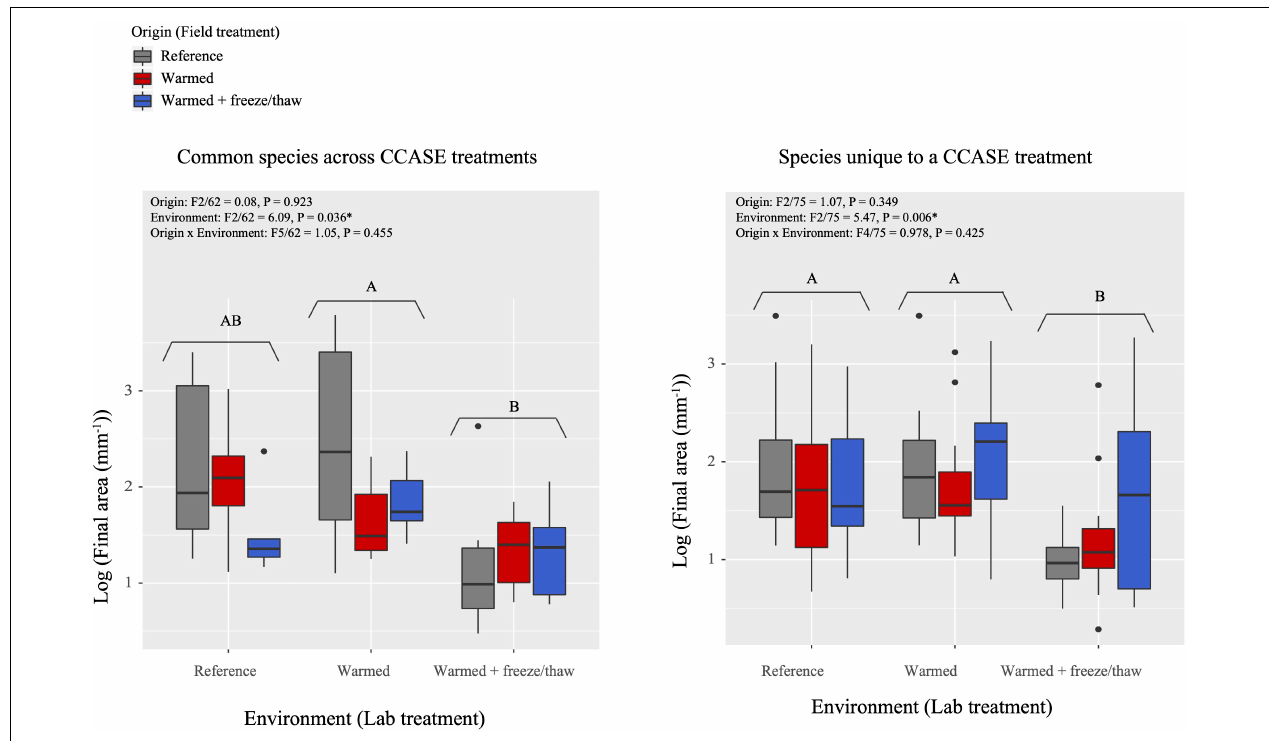
FIGURE 2 | Fungal growth rates, as measured by final area of fungi isolated from CCASE plots after 4 weeks’ incubation in the laboratory common garden experiment. Common species (A) consist of nine species, each isolated from two CCASE treatments: reference and warmed plots ( n = 4), reference and warmed + FTC plots ( n = 3), and warmed and warmed + FTC plots ( n = 2). Unique species include 20 species, each found in only one CCASE